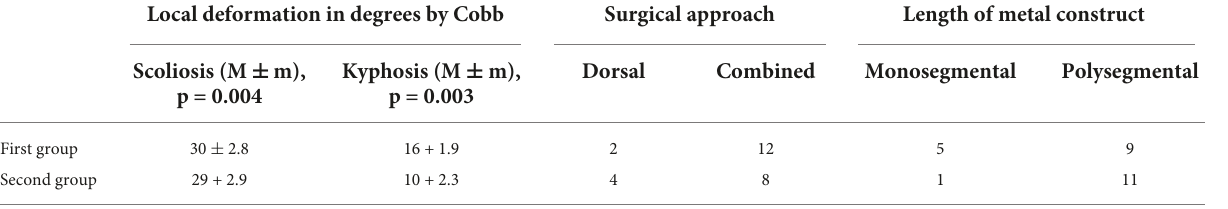
TABLE 2 Characteristics of indicators of spinal deformity and features of surgical treatment. Local deformation in degrees by Cobb